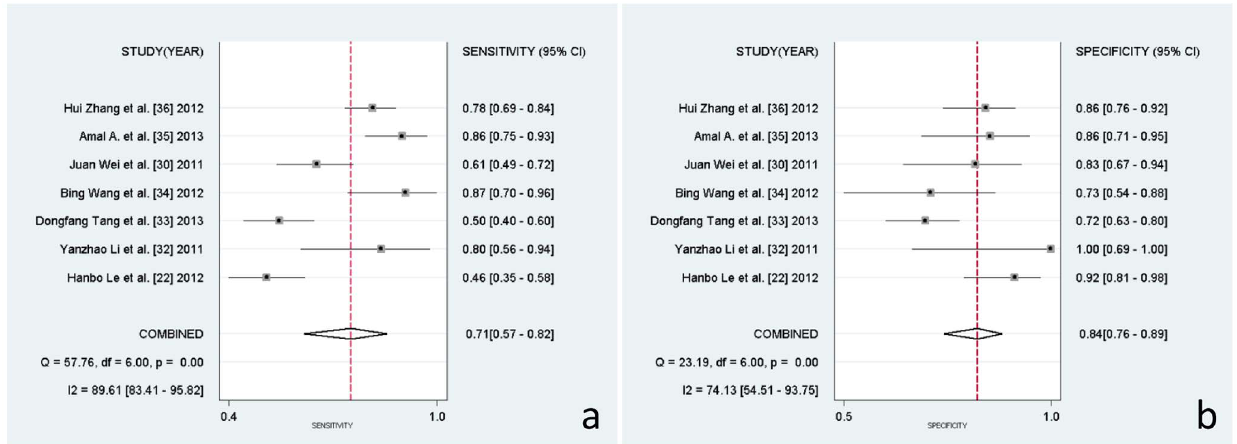
Figure 2. Forest plots of sensitivities and specificities for miR-21 test accuracy in lung carcinoma.